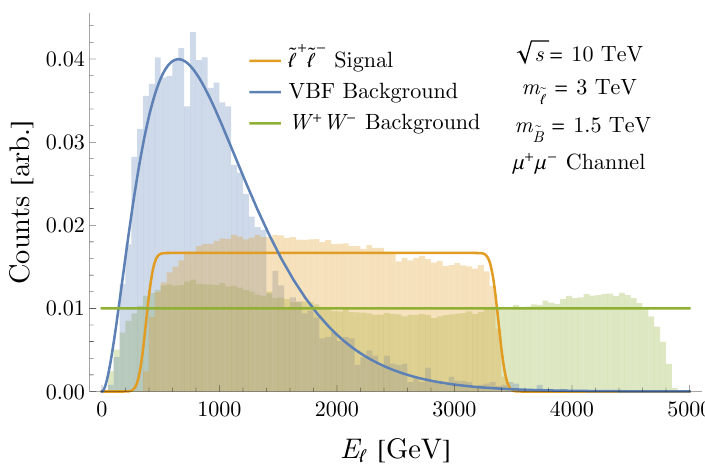
Figure 11. Normalized histograms of the slepton-pair signal and the WW and VBF backgrounds, together with plots of the normalized p.d.f.s, with best fit values of the nuisance parameters.